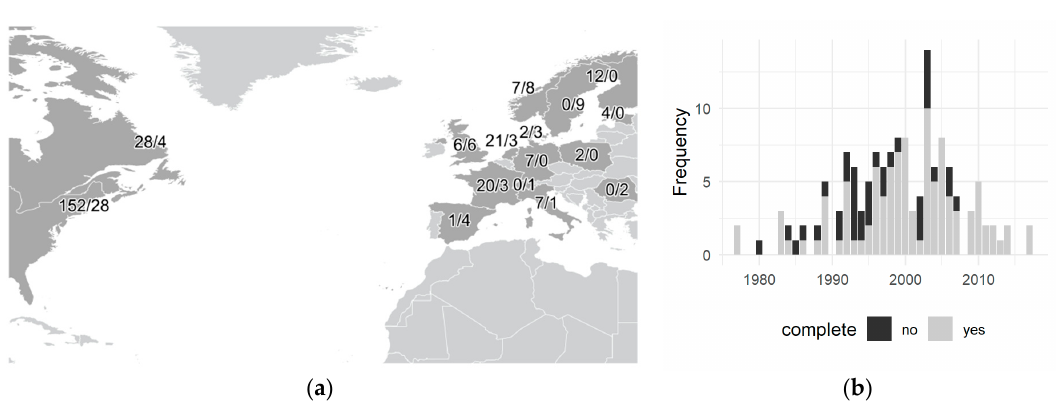
Figure 1. Overview of collected data; ( a ) complete/incomplete datasets per country (n = 341, cf. Table 2), ( b ) number of studies per publication year ( n = 139). Table 2. Completeness of literature